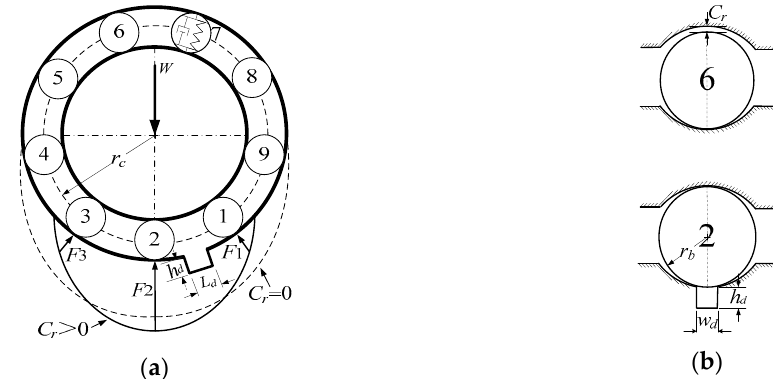
Figure 1. Spall in outer raceway: ( a ) Front view of bearing with spall; ( b ) View along with ball rolling direction.